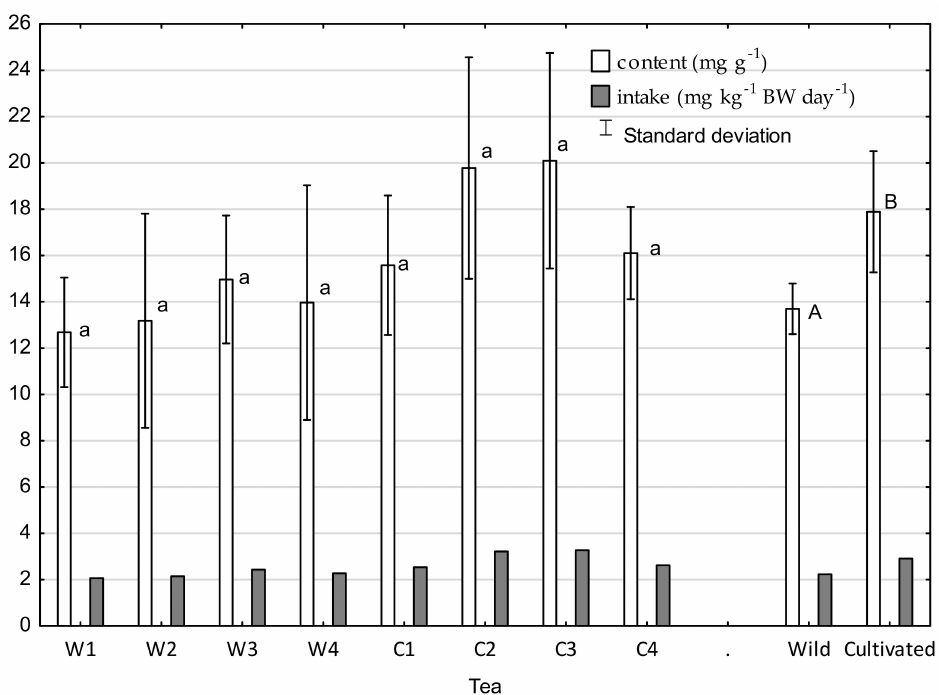
Figure 2. Oxalate concentration in tea and daily intake with tea infusion. Means with different letters are significantly different, according to Tukey’s test ( p ≤ 0.05). W1-wild tea, Wuzhishan; W2-wild tea,